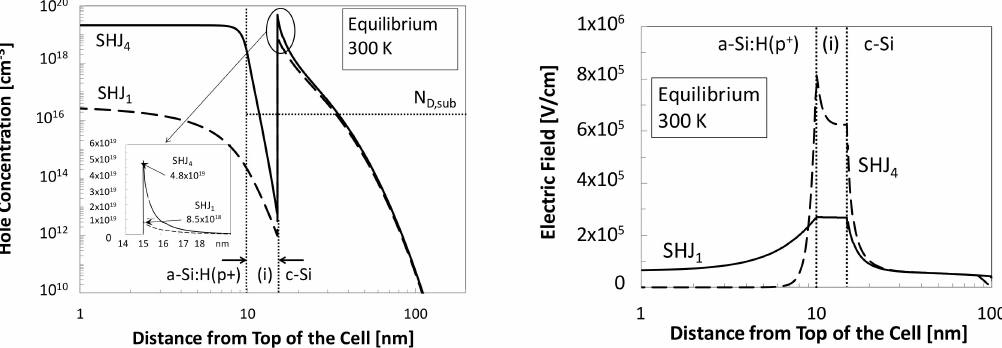
Figure 3. ( a ) Hole concentration profile, and ( b ) electric field distribution, simulated for cells SHJ 1 and SHJ 4 at